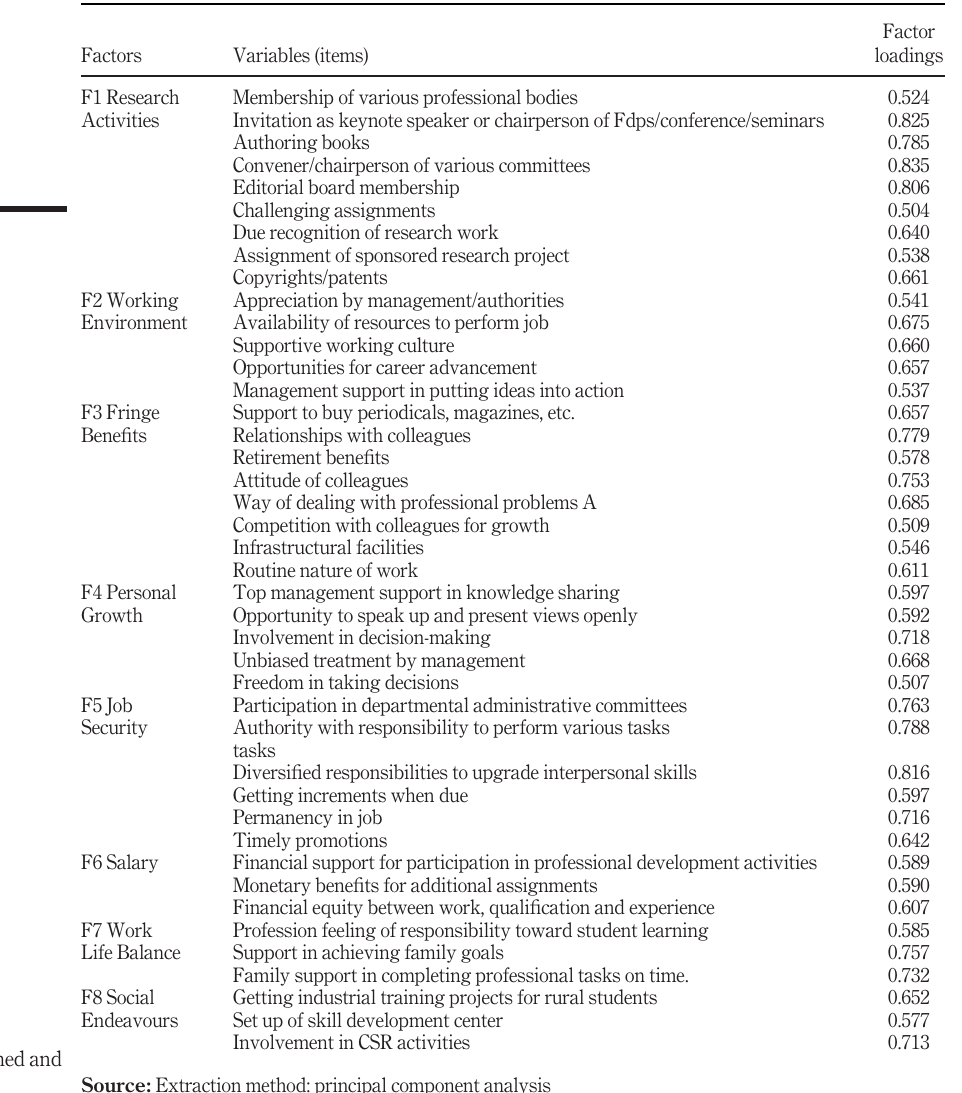
Table III. Factors obtained and their